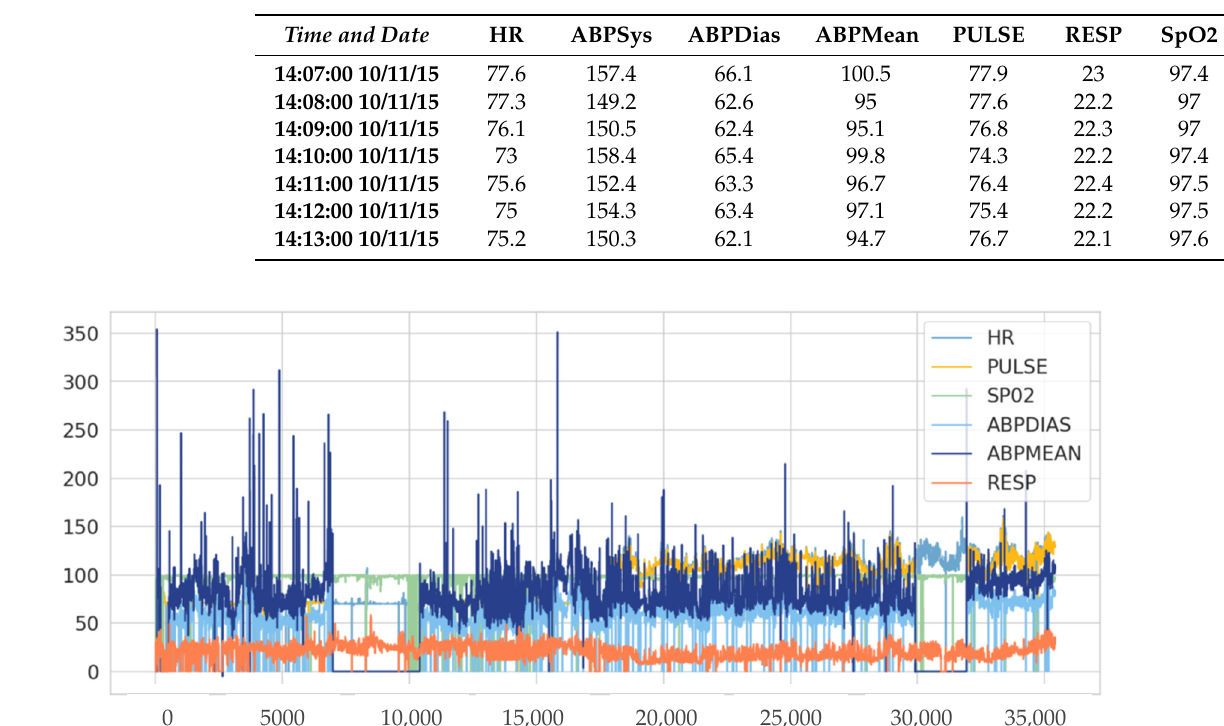
Table 2. Sample of sensor readings for Subject 1 dataset.